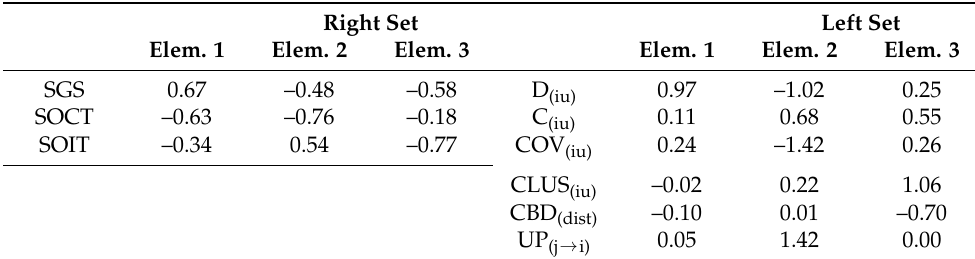
Table 3. Canonical weights for V (4)